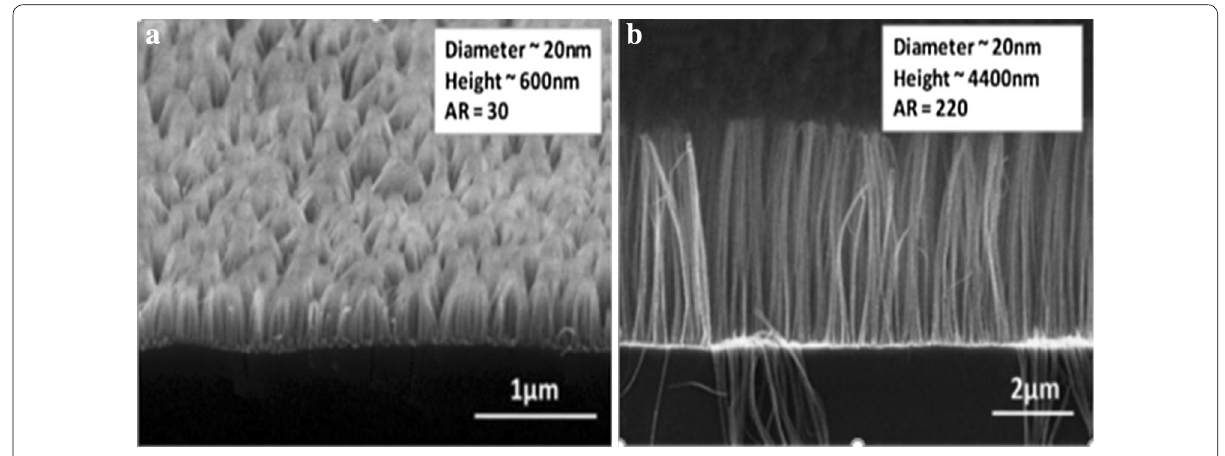
Fig. 6 SEM images of silicon nanowires. a With AR of 30, b with AR of 200